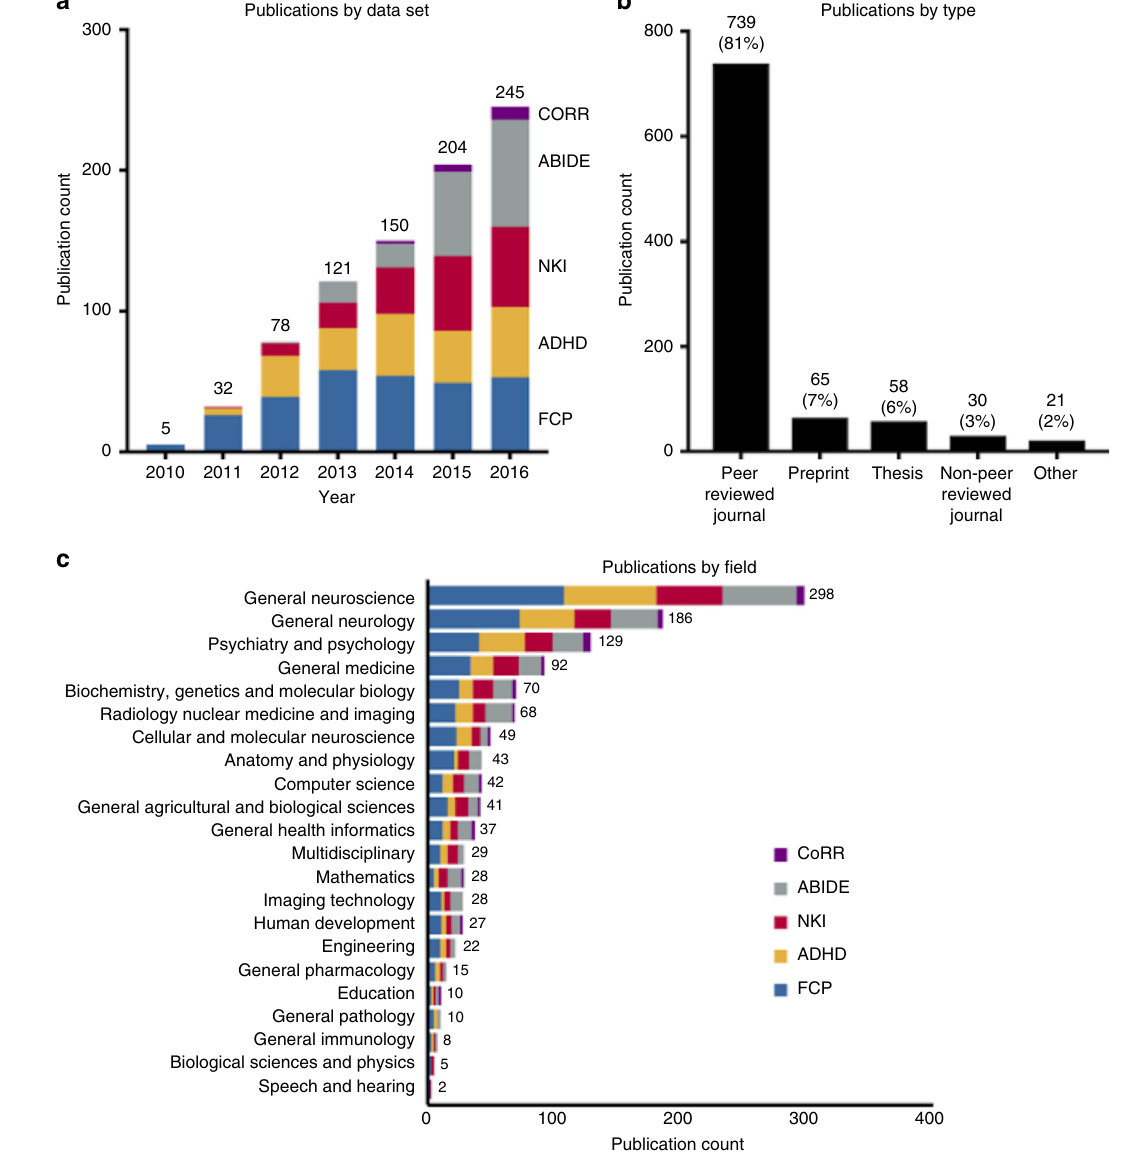
Fig. 1 Publications that used INDI shared data. Publications sorted ( a ) by INDI data set and year, for the period of 2010 – 2016 (2017 is not included since that year was in progress at the time this study was conducted), ( b ) by publication type, and ( c) by journal discipline (limited to peer-reviewed publications and based on Web of Science classi fi